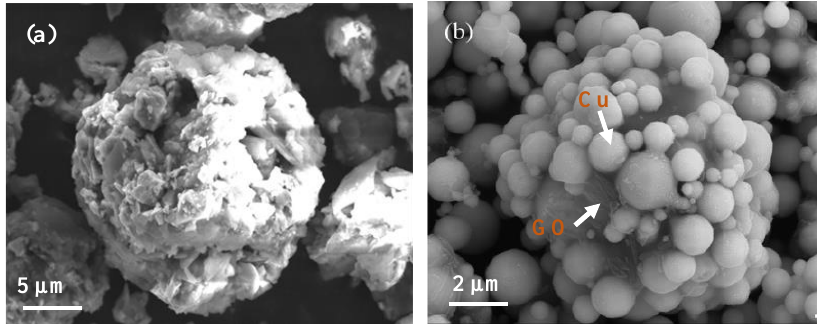
Figure 2. SEM morphologies of ( a ) FeAl 2 O 4 powders and ( b ) Cu/GO composite powders.